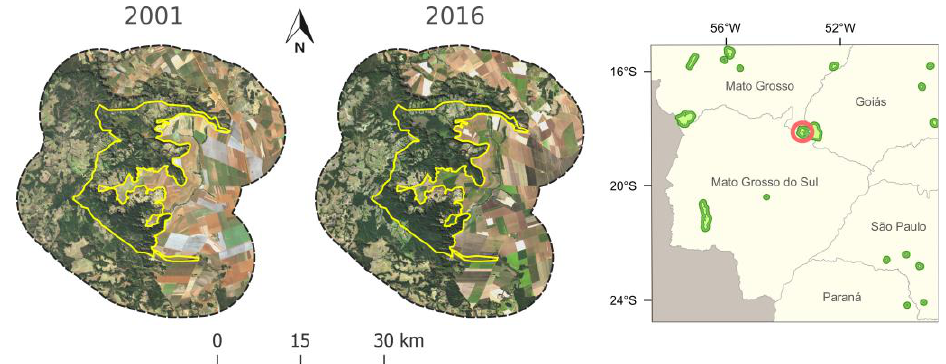
Figure 2. Red-Green-Blue composites of Landsat images (L7/ETM+ of the 09/07/2001 and L8/OLI of the 10/07/2016) showing the landscape of the Parque Estadual das Nascentes do Rio Taquari (boundaries are represented by the yellow outline), its 10 km buffer zone (boundaries are represented by the dashed black outline), and the location of the park (highlighted by the red circle).